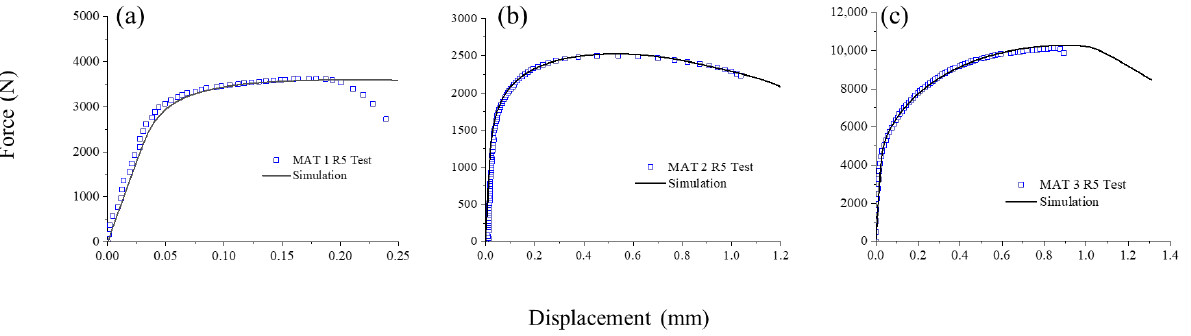
Figure 6. Isotropic hardening-law fittings before necking using R5 test results: ( a ) MAT 1, ( b ) MAT 2, and ( c ) MAT 3. Table 2. Material parameters fitted for three alloys.